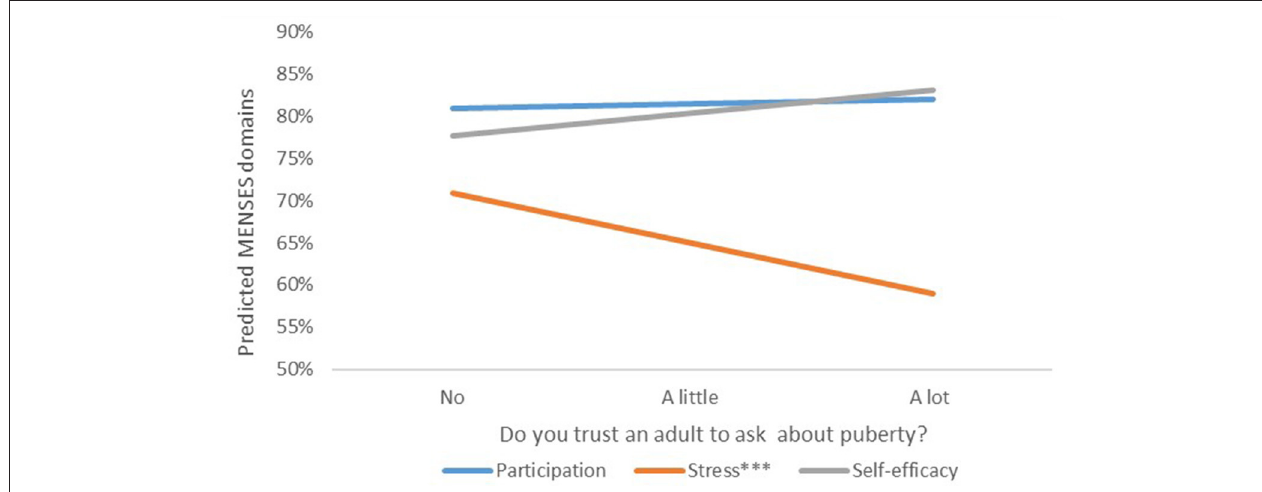
FIGURE 2 | Relationship between MENSES outcomes and trusting an adult to ask about puberty. * p < 0.05, ** p < 0.01, *** p <